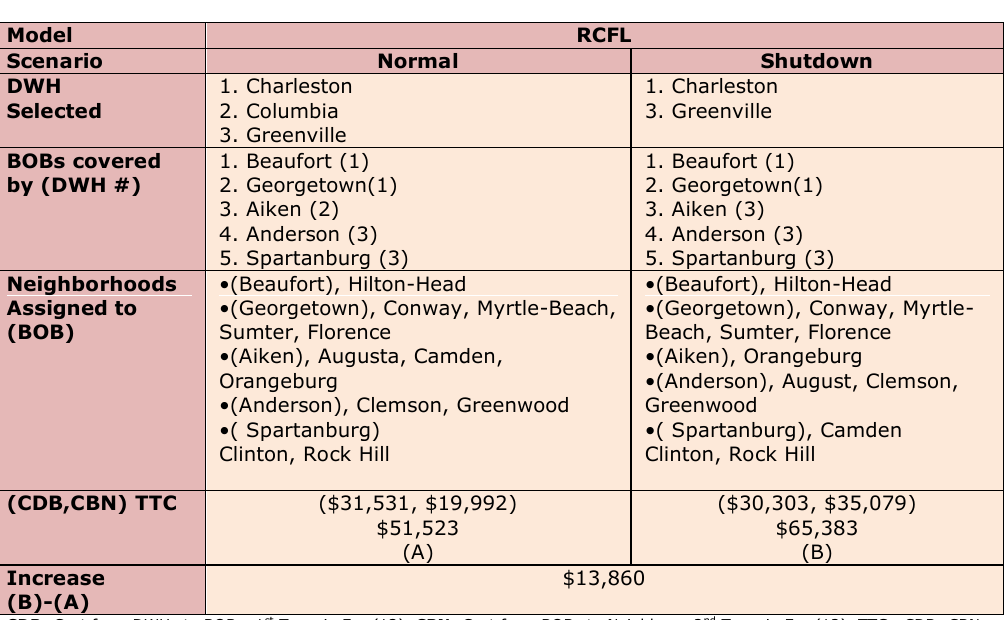
Table 2(c). Results comparison for normal/shutdown scenarios for three models